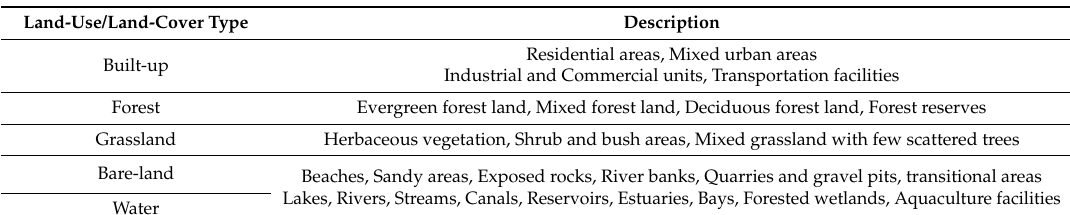
Table 2. Description of Land use/land cover